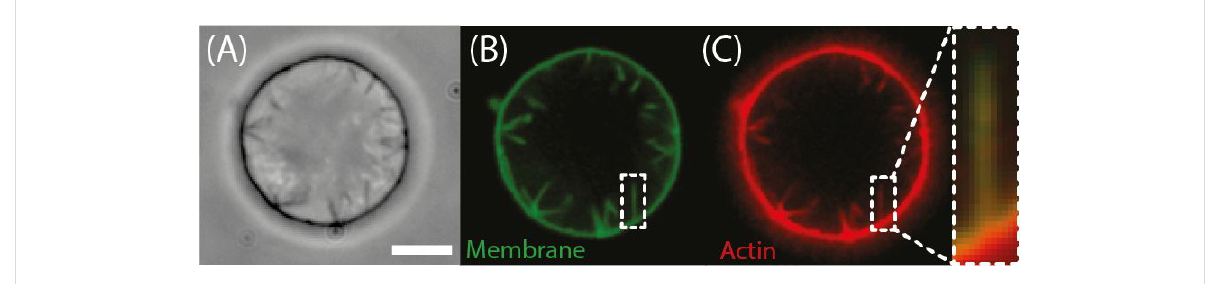
Figure 5: Thin actin protrusions emerge from dendritic actin networks. Phase-contrast (A) and spinning-disc confocal images (B) of lipid membrane (green) and (C) actin (red) show multiple protrusions in the lumen of a GUV. Overlay of the fluorescence images confirms that the membrane protru- sions are supported by actin filaments. The scale bar represents 5 μ m. (Reprinted with permission from [67]. Copyright (2008) Nature Publishing